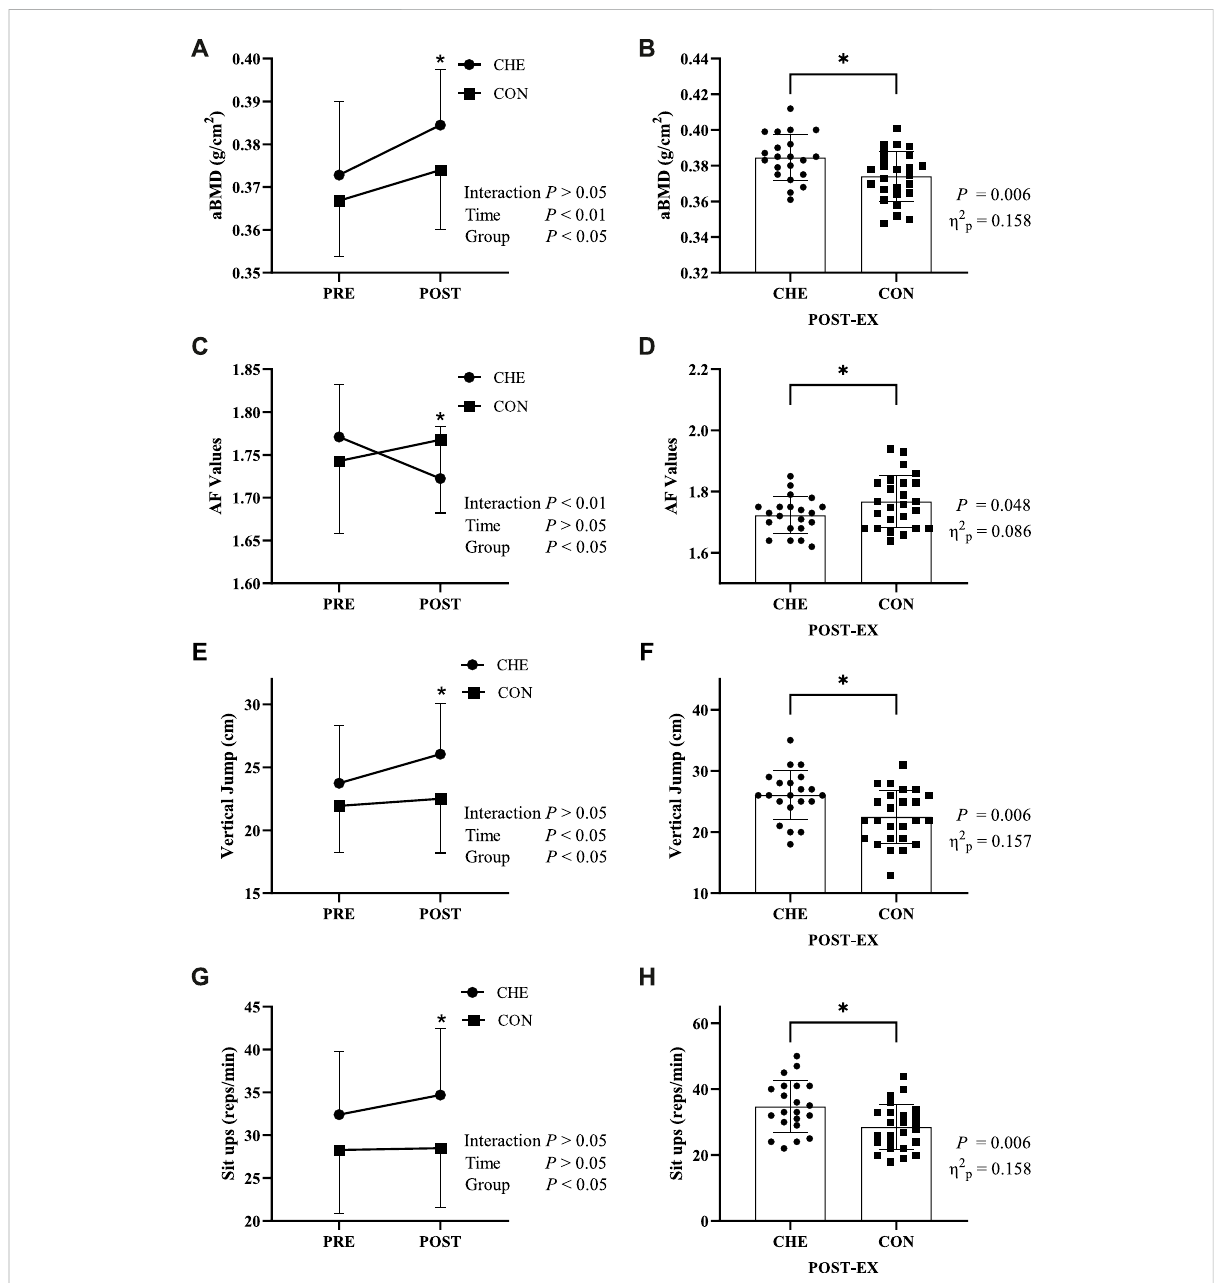
FIGURE 2 Changes in indicators before (PRE) and after (POST) the intervention in the cheerleading group (CHE) and the control group (CON). (A,B) areal bone mineral density (aBMD); (C,D) auto- fl uorescence (AF) Values; (E,F) vertical jump; (G,H) sit-ups. * indicates a signi fi cant difference between the CHE and CON groups. Interaction: interactive effects; Time: time main effect; Group: group main